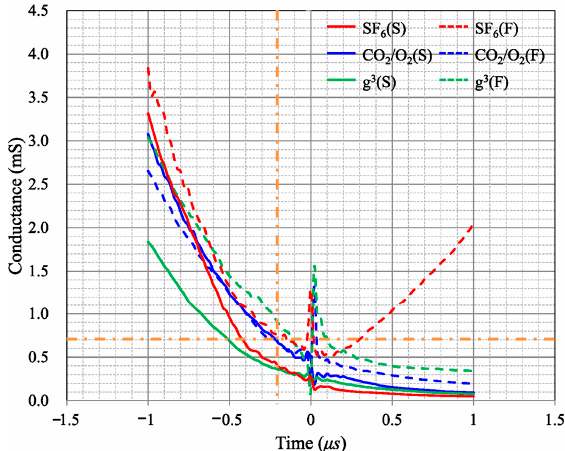
Figure 4. Characteristics of arc conductance according to interrupting success and failure of SF 6 , CO 2 /O 2 , and g 3 gases.